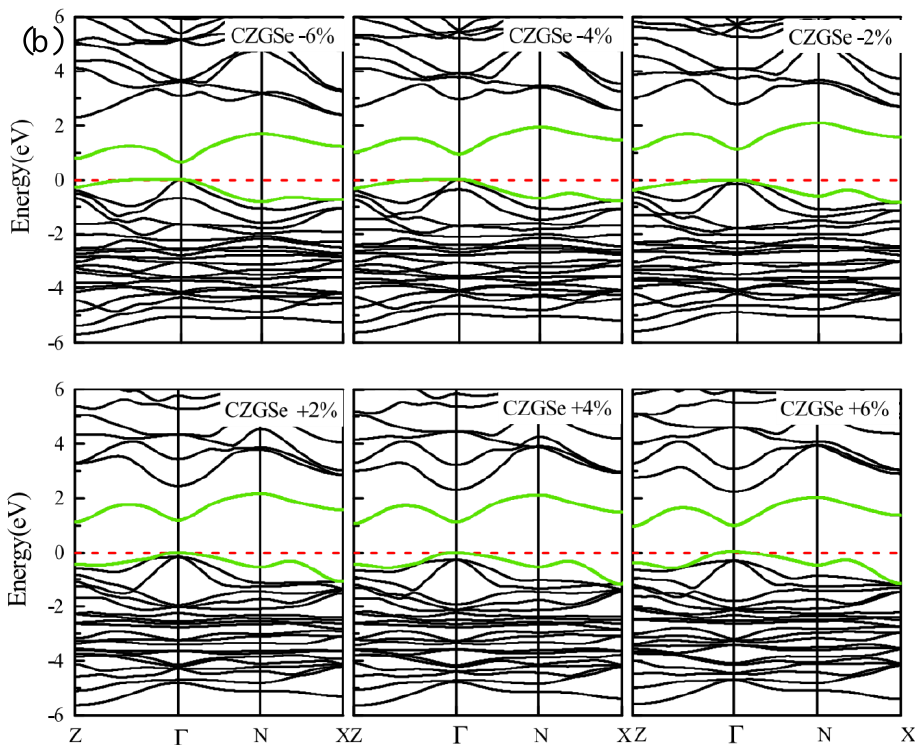
Figure 4. Variation of band structure with lattice parameter deformation ( a ) for CZGS and